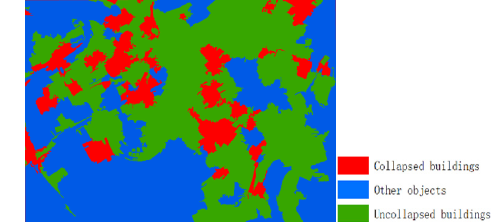
Figure 8. the classification result of building damage